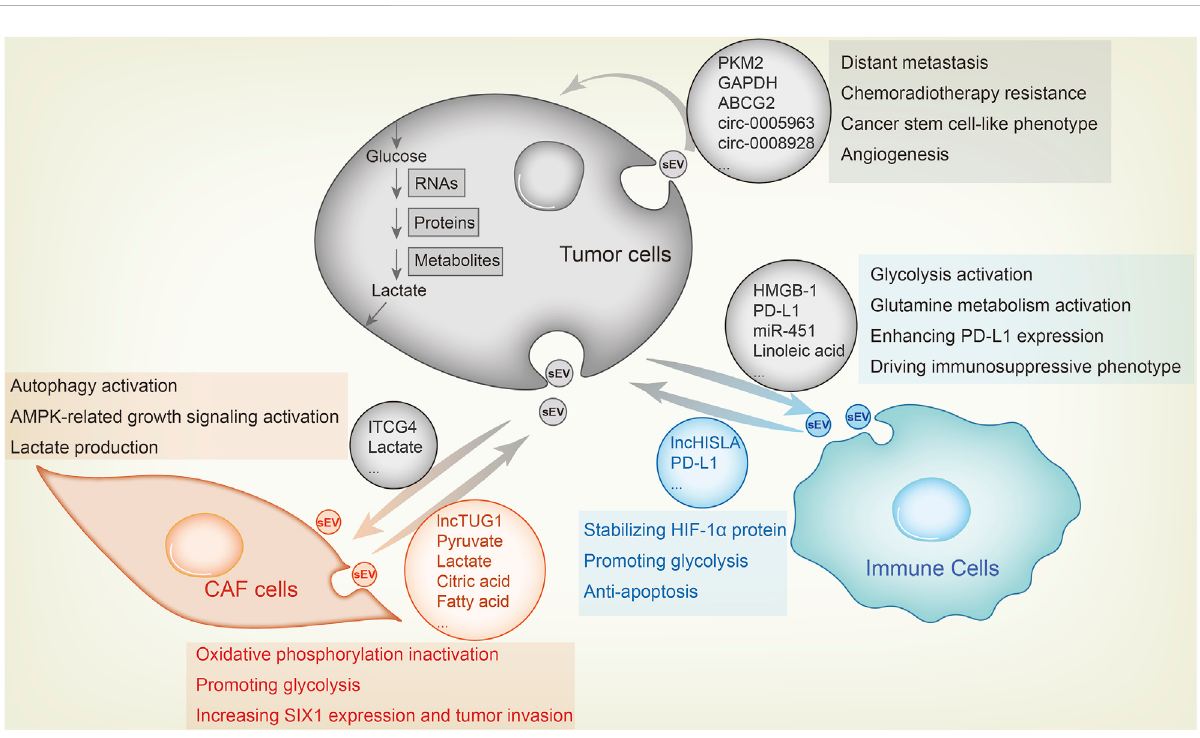
FIGURE 2 Metabolic sEV exchange between tumor cells and other components in the TME. The uptake of tumor-derived sEVs by CAFs or immune cells facilitates tumor growth, whereas tumor cell fusion of metabolic sEVs in TME leads to its malignant transformation. For example, CAFs-derived sEV lncRNA TUG1 delivers to liver cancer cells, increasing SIX1 expression and promoting glycolysis and tumor invasion. CAFs-derived sEVs inhibit oxidative phosphorylation and activates glycolysis by delivering lactate, pyruvate, citric acid, fatty acids and amino acids to pancreatic cancer cells. As feedback, breast cancer cells sEVs carry ITGB4 proteins that can be transmitted to CAFs, inducing autophagy, AMPK activation and lactate production in CAFs, which contribute to tumor invasion. As for the effect of sEV on immune cells, lung cancer-derived sEV HMGB1, PD-L1 and linoleic acid enhance glycolysis, glutamine metabolism and PD-L1 expression in macrophages and T cells through NF- κ B signaling, endowing these immune cells with an immunosuppressive phenotype. MiR-451 in sEV of gastric cancer transmits to T cells and enhances their in fi ltration, causing them to differentiate to Th17 cells and forming malignant transformation of tumor microenvironment. Macrophages also secrete sEVs, which enhance aerobic glycolysis and anti-apoptosis of breast cancer cells by delivering lncRNA HISLA and stabilizing HIF-1 α protein. Among tumor cells, highly metastatic cells, chemotherapy or radiotherapy resistant cells and cancer stem cell-like cells transfer sEV to sensitive cells to confer corresponding malignant